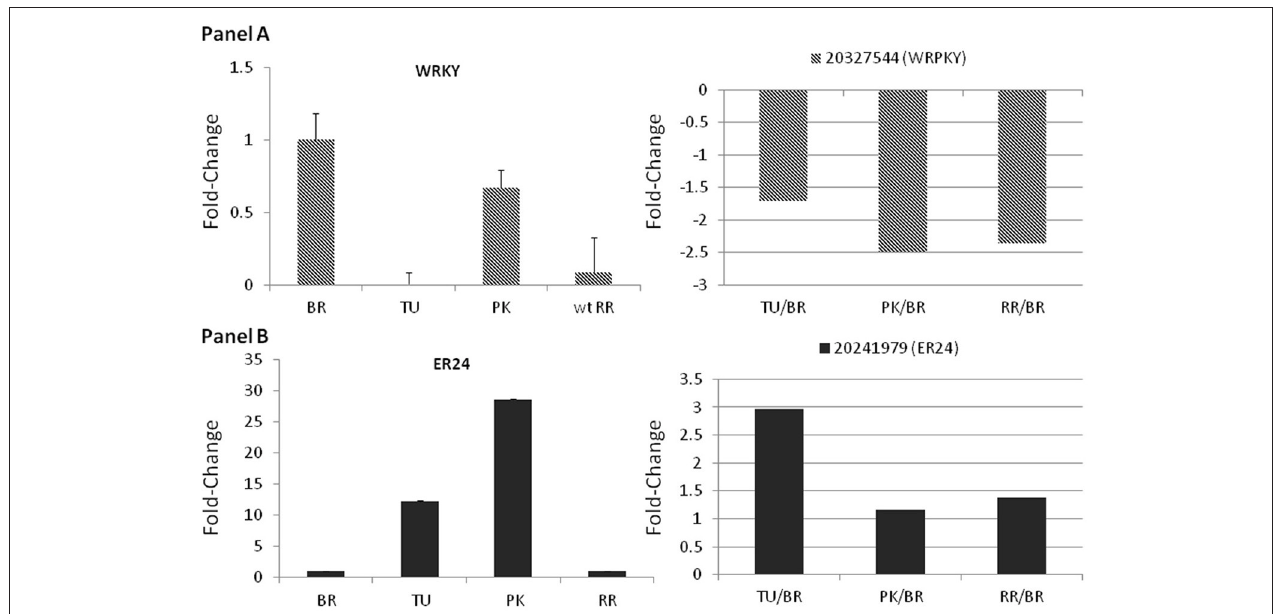
FIGURE 5 | Fold-changes of the WRKY22 and the ER24 using qPCR (left panels) and microarray data (right panels). Relative fold changes were calculated based on the comparative Ct method, using actin as an internal standard. The Ct value for each gene was normalized to the Ct value for actin and was calculated relative to a calibrator (Breaker) using the formula 2_DDCt. Average _standard errors (S.E.) of three biological replicates for each stage was estimated. Microarray fold-changes are estimated in relation to the Breaker stage.